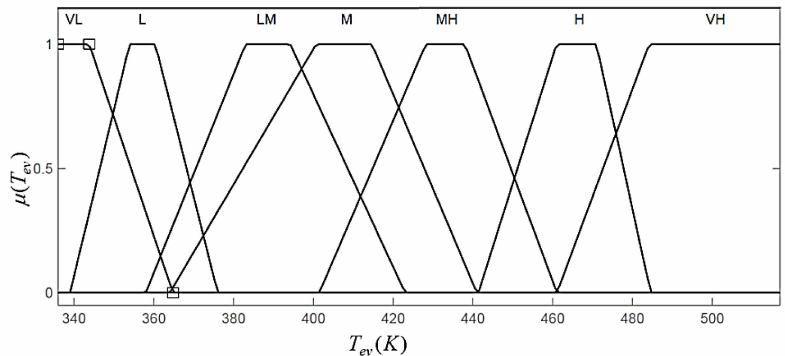
Figure 17. Membership functions of evaporator outlet temperature.